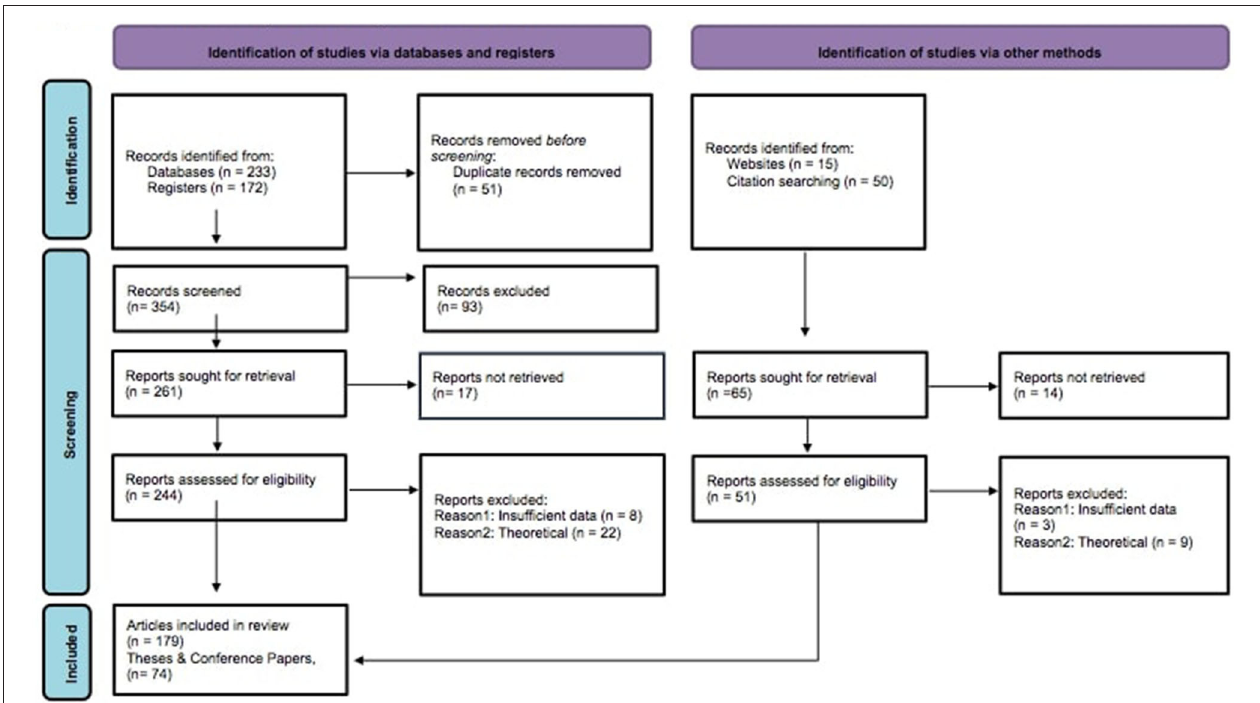
FIGURE 1 | PRISMA flow diagram for new systematic reviews. Source: Page et al. (2021).